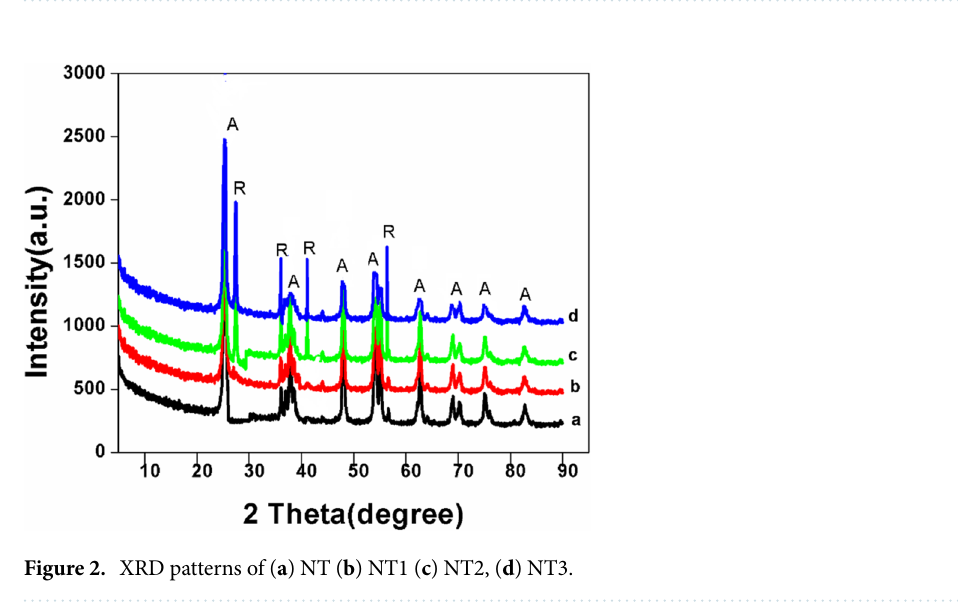
Figure 1. Thermal curve of as synthesized NT.